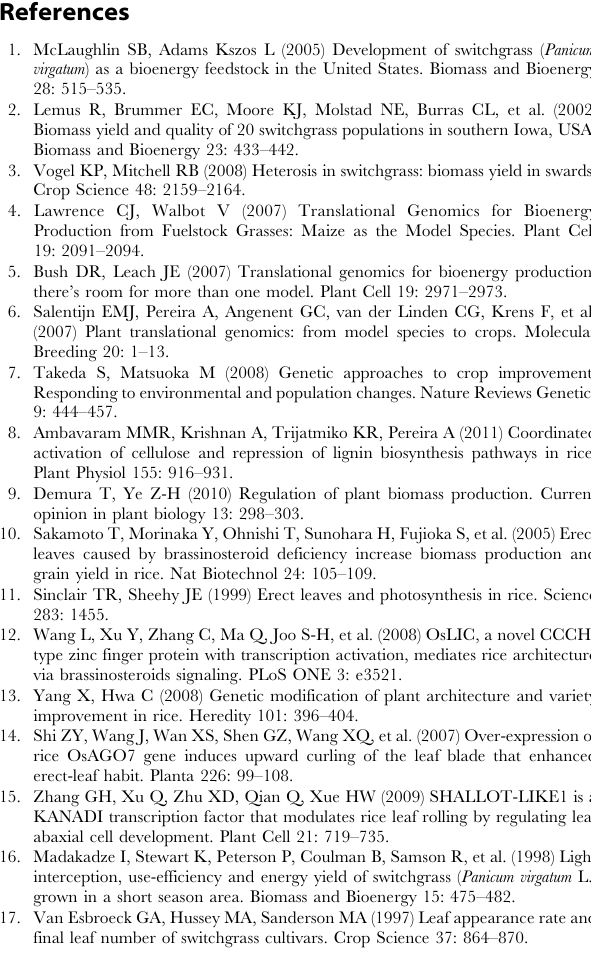
Table S1 Primers used for PCR and RT-PCR. Table S2 Primers used in qRT-PCR for the validation of ten selected genes identified by microarray analysis. Table S3 Differentially expressed genes in AtLOV1 transgenic switchgrass. | | | |, no information available; NA, homologs cannot be